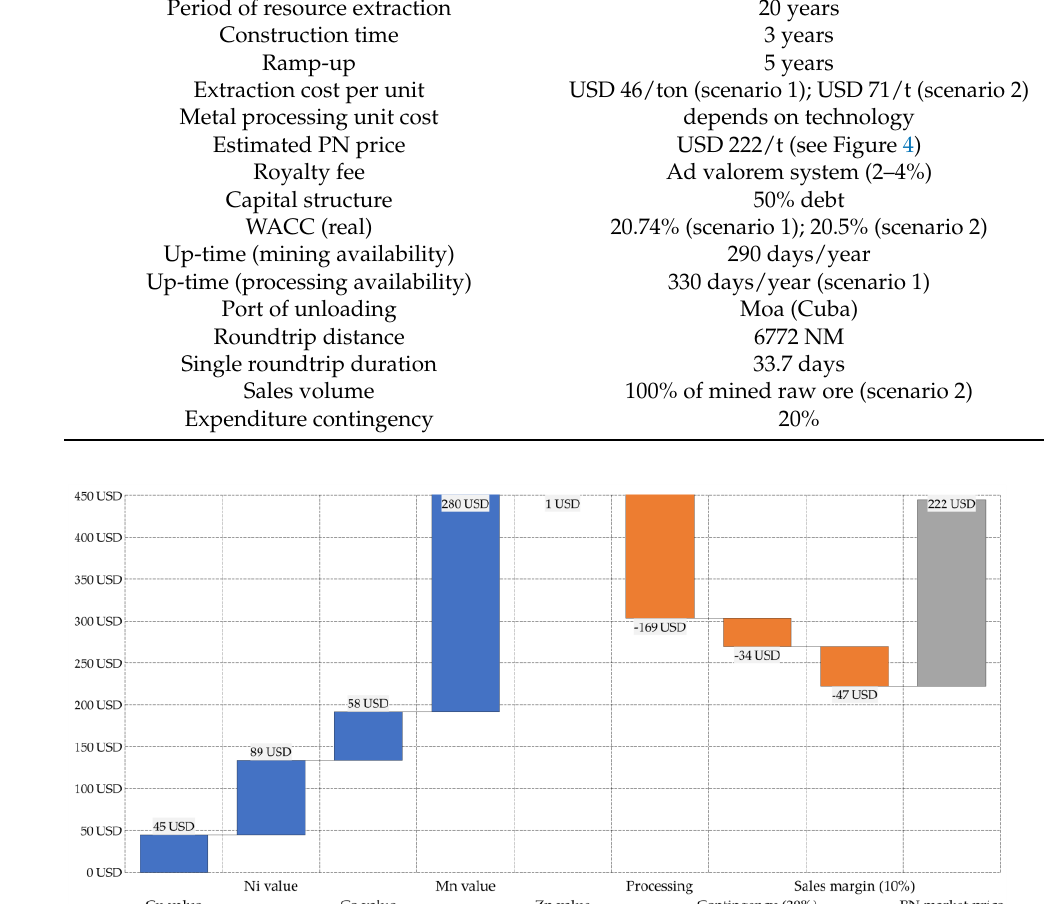
Table 9. Main economic assumptions made for the considered scenarios.